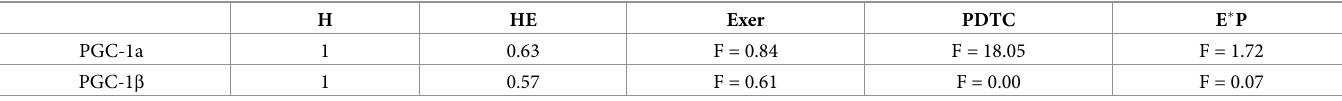
Table 1. Effect of PDTC on the relative content of various genes in the extensor digitorum longus. H